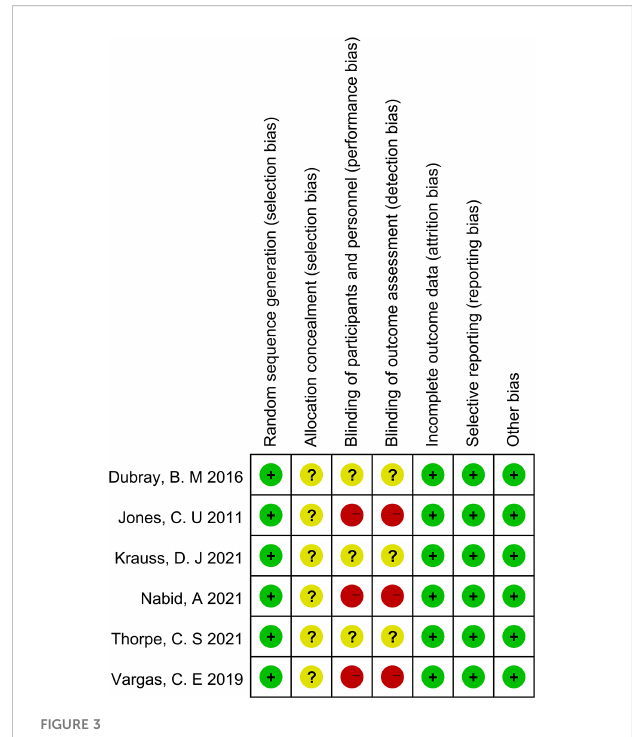
FIGURE 3 Risk of bias summary for 6